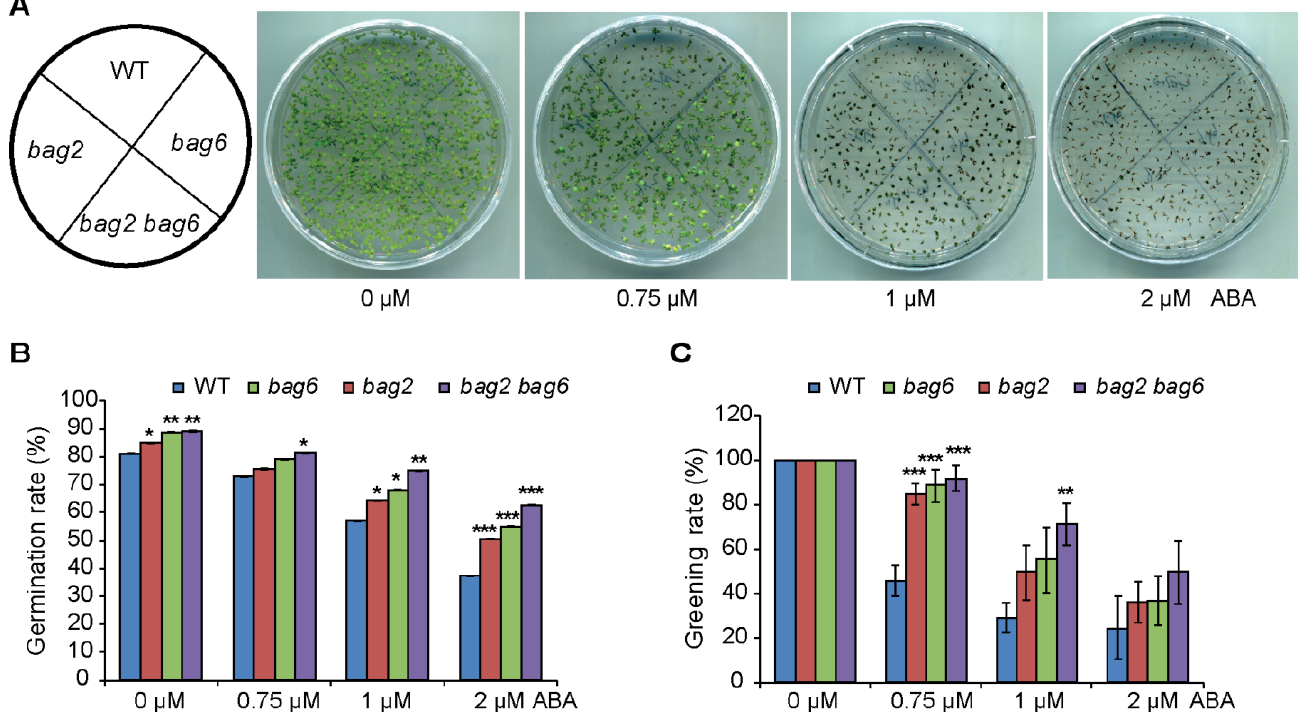
Figure 4. bag2 and bag6 mutants are less sensitive to ABA than the WT. ( A – C ) Seed germination rate and greening rate of WT, bag2 and bag6 single, and bag2 bag6 double mutants. Sterilized seeds were sowed on MS medium supplemented without or with different concentrations of ABA. The germination percentage and the greening rate were scored. All the data represent the means of three independent experiments ± SD. * represent the significant differences at p < 0.05; ** represent p < 0.01; *** represent p < 0.001 (Student’s t -test).